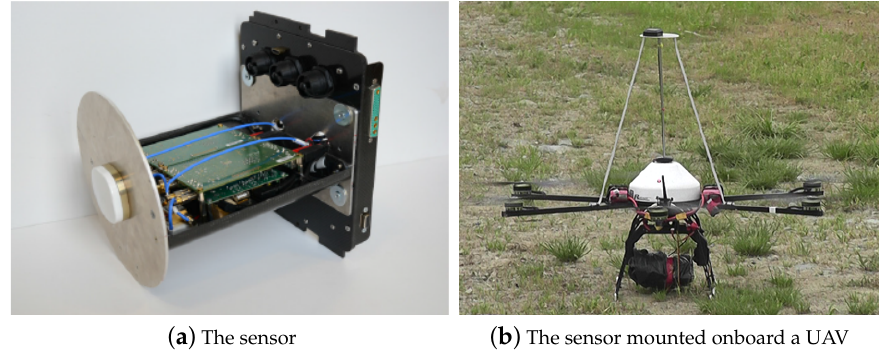
Figure 1. The global navigation satellite systems (GNSS)-R sensor used in this study, and a picture from one of the data collection